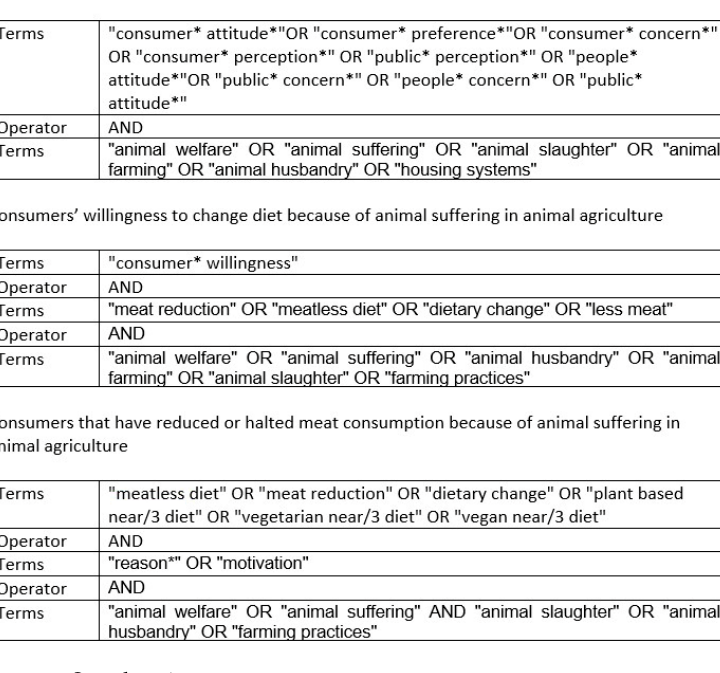
Figure 1. Search strings.